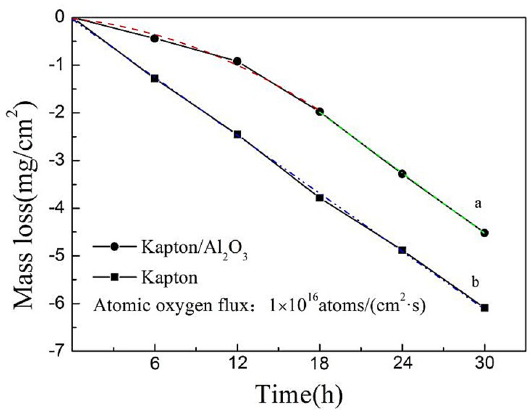
Figure 10. Mass loss after atomic oxygen exposure of the Kapton film and Kapton/Al 2 O 3 surface nanocomposite film.